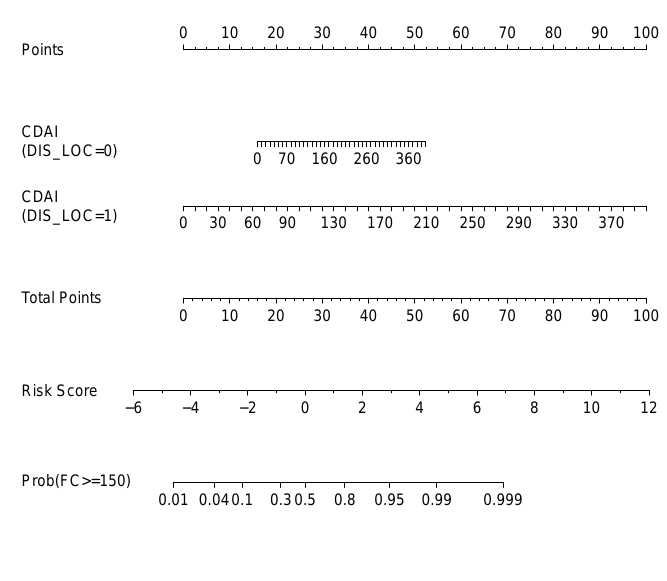
Figure 6 – Nomogram for computing the estimated risk of an active disese The location disease establishes which CDAI scale must be used. Therefore based on the CDAI score the corresponding total point value can be read on the ”Total Points” axis. Therefore, the probability of FC ≥ 150 µg/g for each subject can be calculated from the scale presented on the bottom